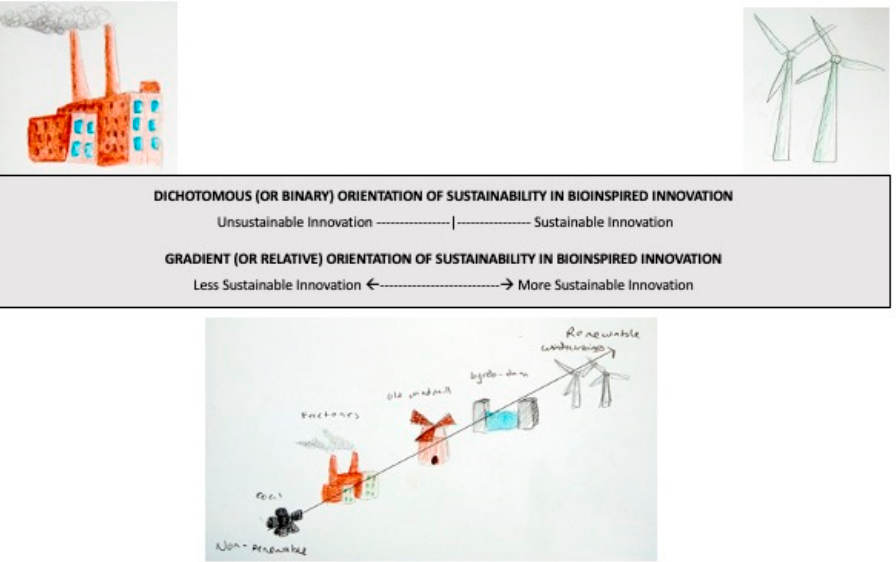
Figure 3. Dichotomous versus gradient orientation of sustainability in BII (adapted from [50], p. 226).